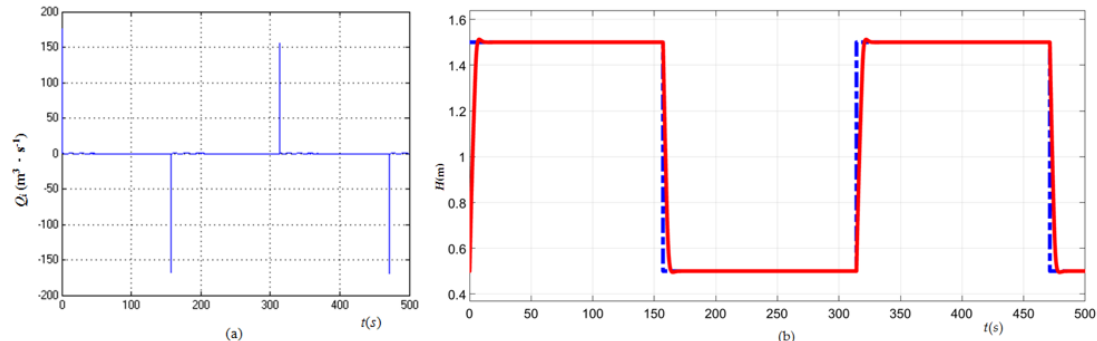
Figure 9. (a) and (b). Simulation results of nonlinear feedback control with limited flow rate. The inflow rate is 0.4 m 3 /s. (a) Curve of control input. (b) Curve of water level.